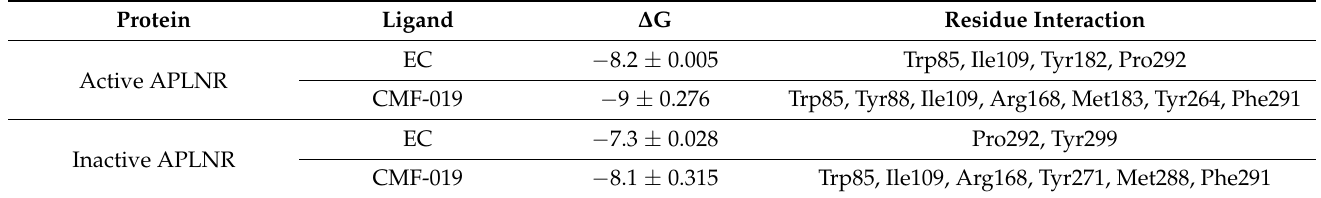
Table 4. Summary of the data obtained from the molecular docking assay of EC and CMF-019 against iAPLNR and aAPLNR. ∆ G values are presented as mean ± standard